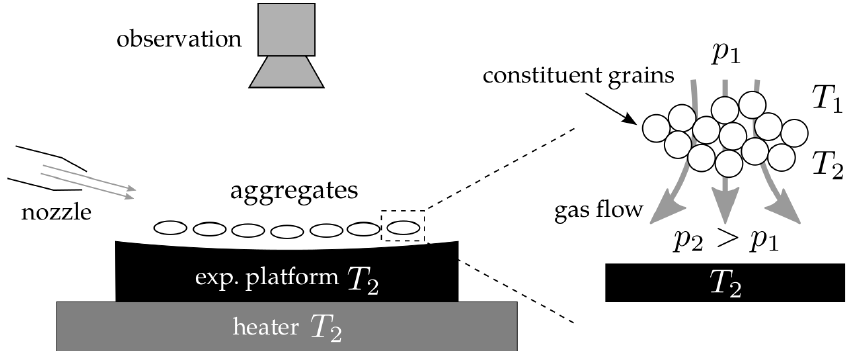
Figure 3. At low ambient pressures, thermal creep through dust aggregates generates an air cushion for the aggregates to levitate upon (from Kelling et al.